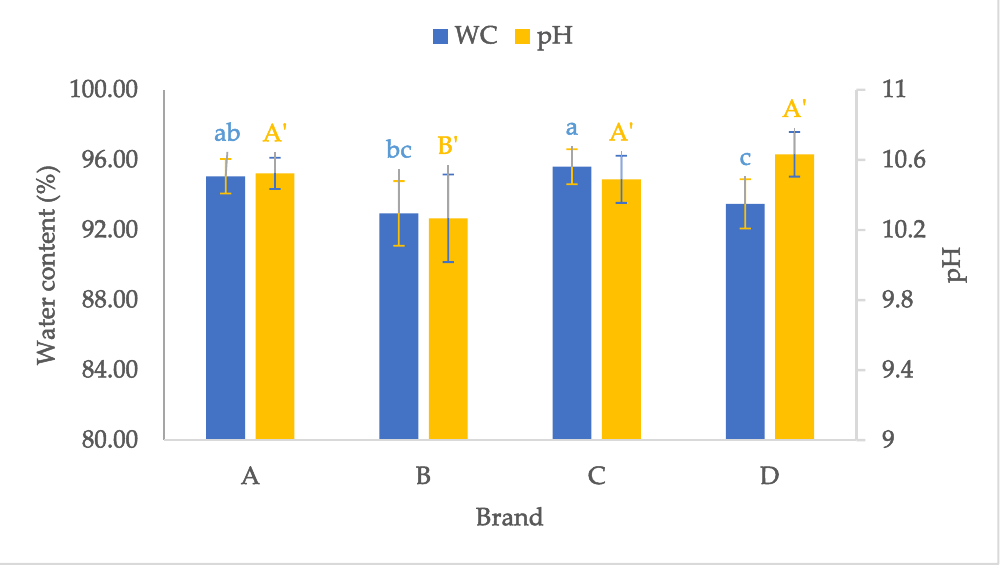
Figure 1. Mean values for water content (WC) and pH of the four (A, B, C, and D) lutefisk brands. The small letters and capital letters with an apostrophe indicate significant differences for the WC and pH, respectively.